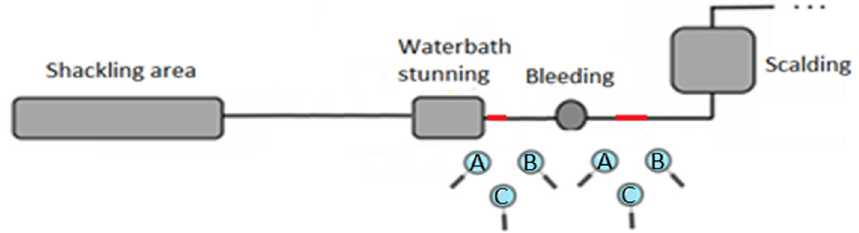
Figure 1. Position of the observers (A to C) during the assessment of ABIs in terms of the effectiveness of waterbath stunning in broilers. The position of the lens is the position of the observers (i.e., before and during bleeding) and the red segments are the observation areas.